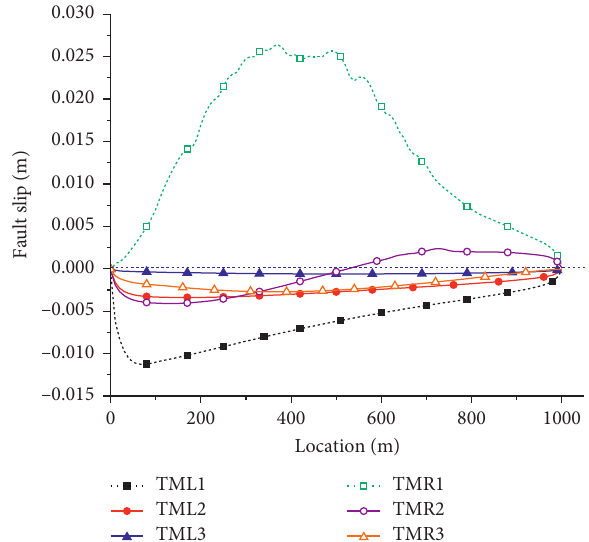
Figure 10: Fault slip along the fault plane when region TM changed in the horizontal